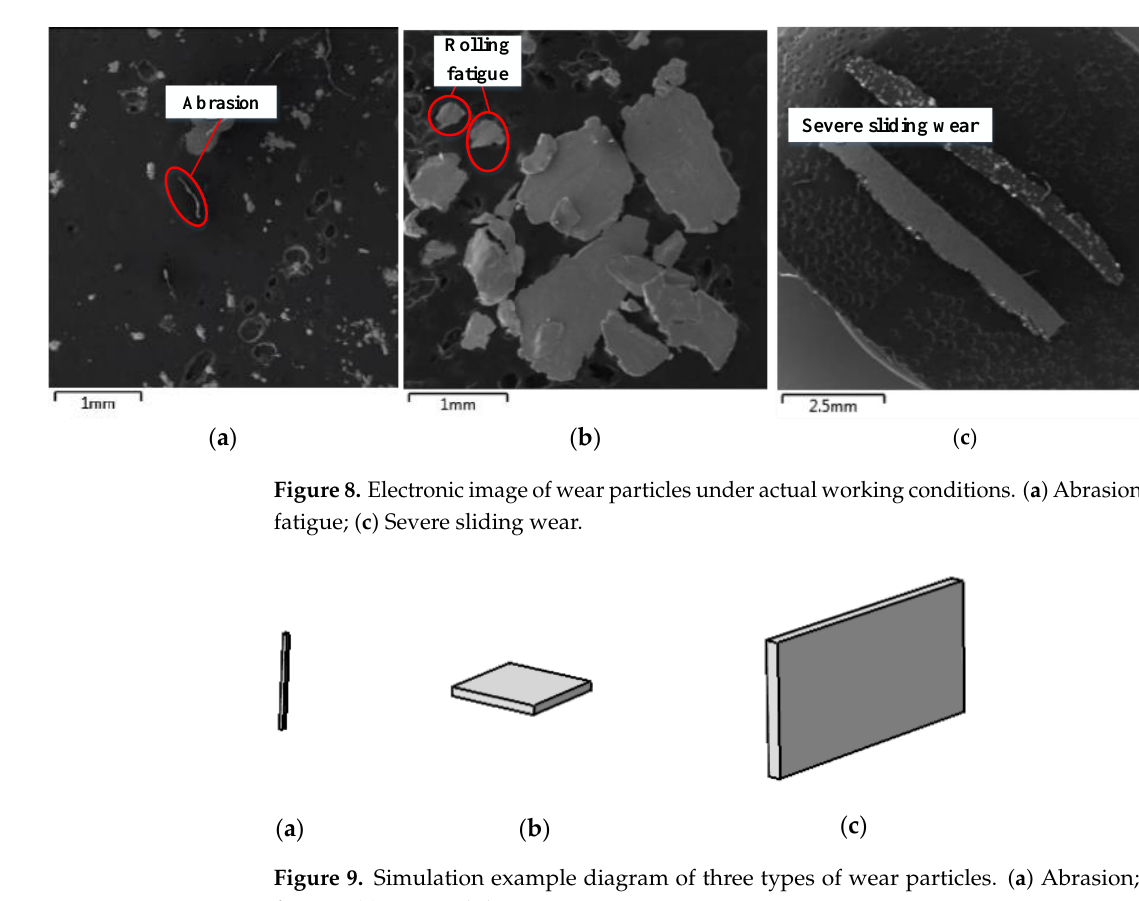
Figure 8. Electronic image of wear particles under actual working conditions. ( a ) Abrasion; ( b ) Roll- ing fatigue; ( c ) Severe sliding wear.